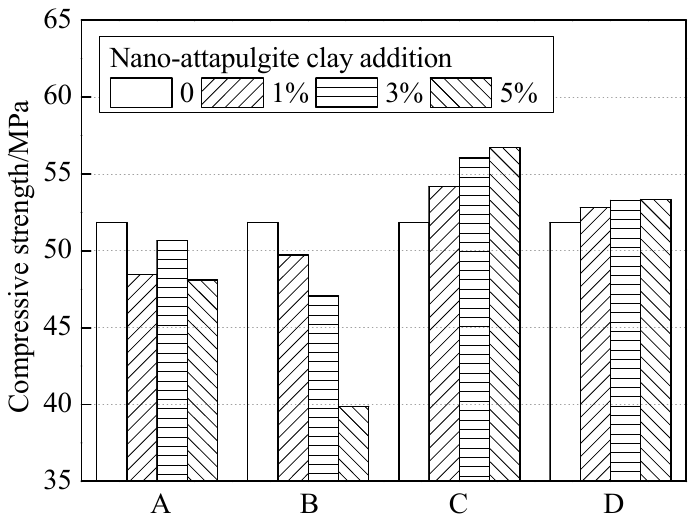
Figure 12. Compressive strength of cement paste with various NAC addition.